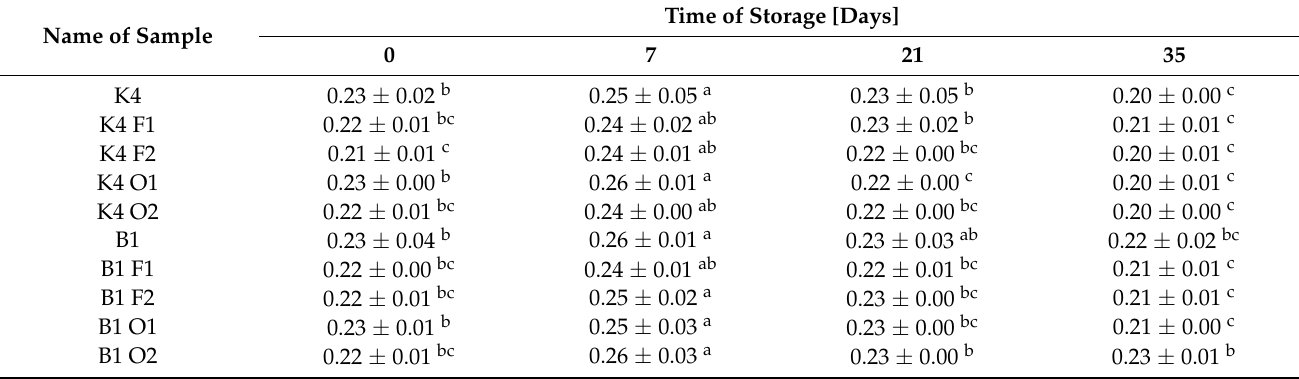
Table 3. Changes in firmness values ± SD (N) in fermented milk samples during